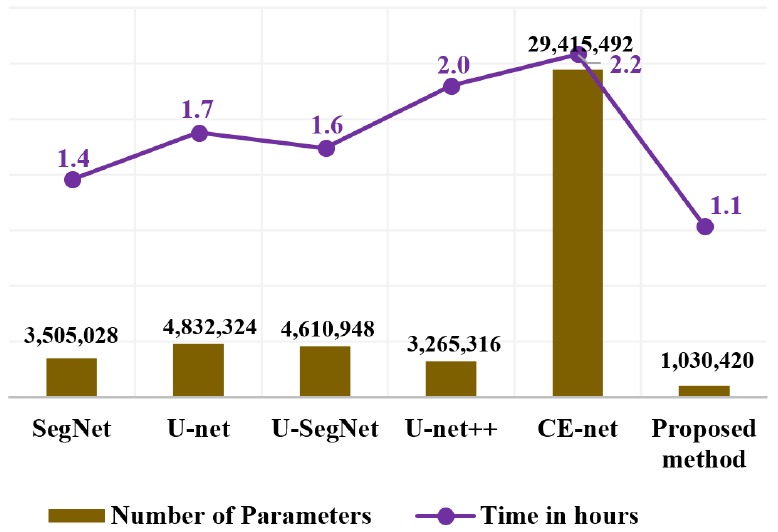
Figure 9. Detailed data on the number of learnable parameters and computation time for the pro- posed and conventional methods for the OASIS